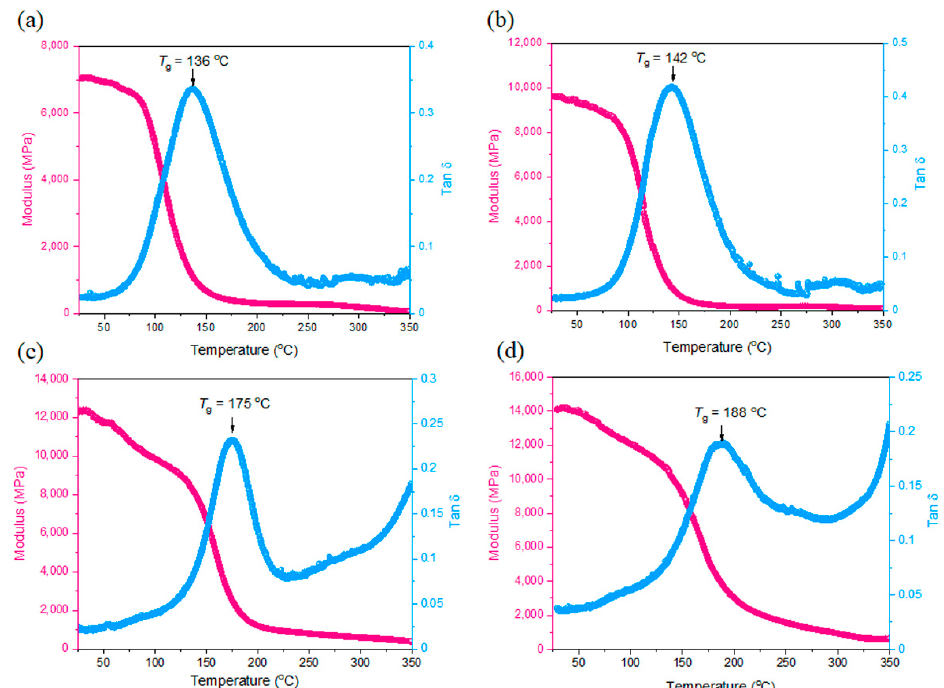
Figure 6. DMA analyses of ( a ) epoxy/BMI = 3/1, ( b ) epoxy/BMI = 1/1, ( c ) epoxy/DDSQ-BMI = 3/1, and ( d ) epoxy/DDSQ-BMI = 1/1 hybrids after thermal polymerization procedure where pink line is storage modulus and blue line is tan δ .